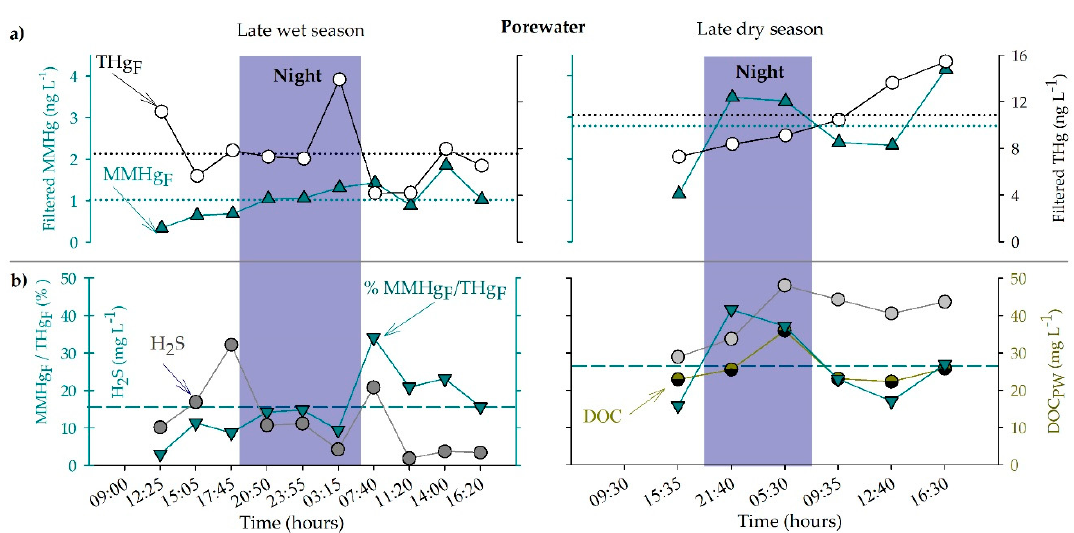
Figure 3. ( a ) Filtered (F) THg (empty circles) and MMHg concentrations (dark cyan triangles up) and ( b ) percentage MMHg over the THg concentrations (dark cyan triangle down), dissolved organic carbon (DOC, semi-filled dark yellow circles), and hydrogen sulfide (H 2 S, grey circles) concentrations in sediment porewater during the wet (left panels, 20–21 May 2014) and the dry (right panel, 18th to 19th November 2014) seasons. Lines represent average concentrations for F (dotted line) and MMHg / THg (dashed line) concentrations and